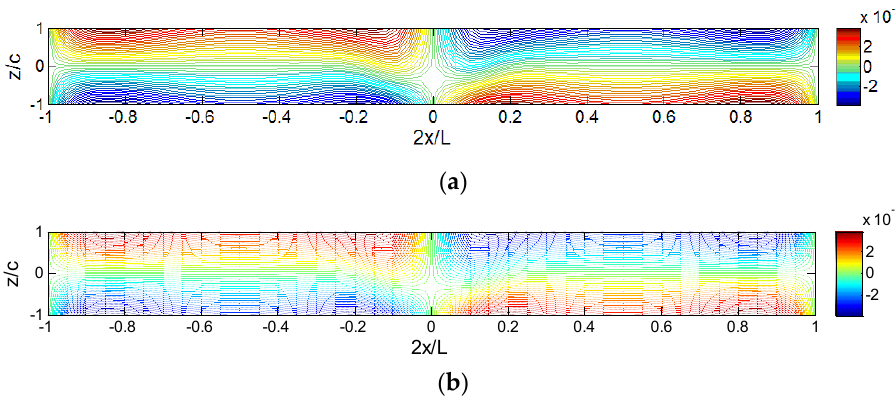
Figure 3. Comparisons of iso-displacement ( u / w n ) diagram for sandwich panels under locally distributed loads ( Lp = 0.1 L ): ( a ) HDQM (harmonic differential quadrature method); and ( b ) ABAQUS.